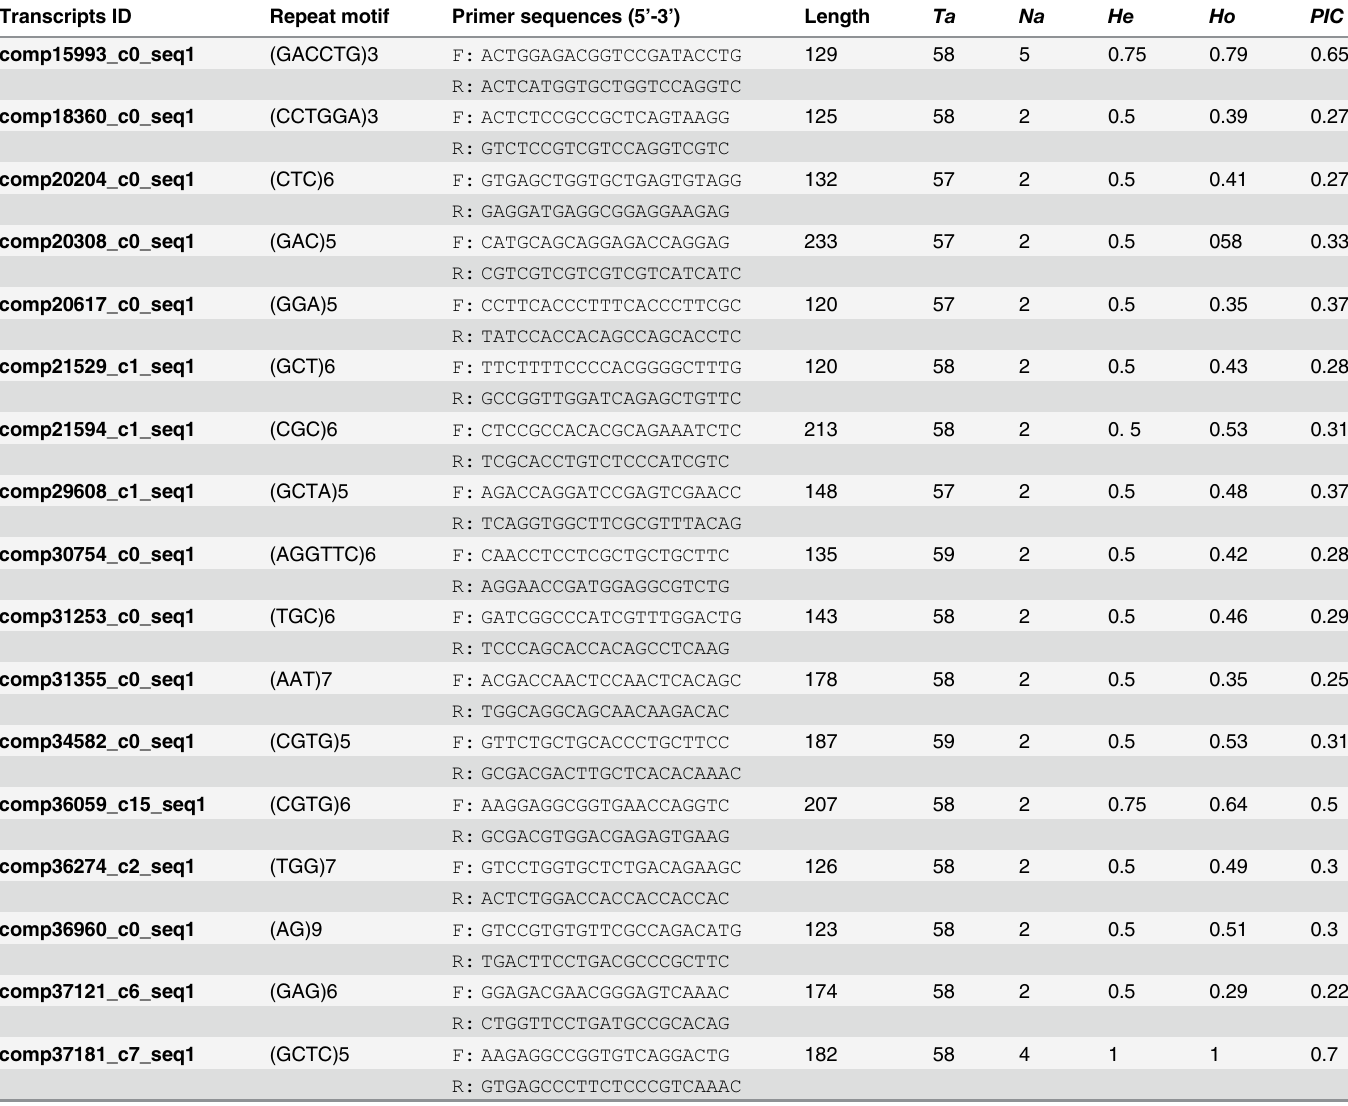
Table 5. Characterization of 17 polymorphic SSR loci in a turbot family of 90